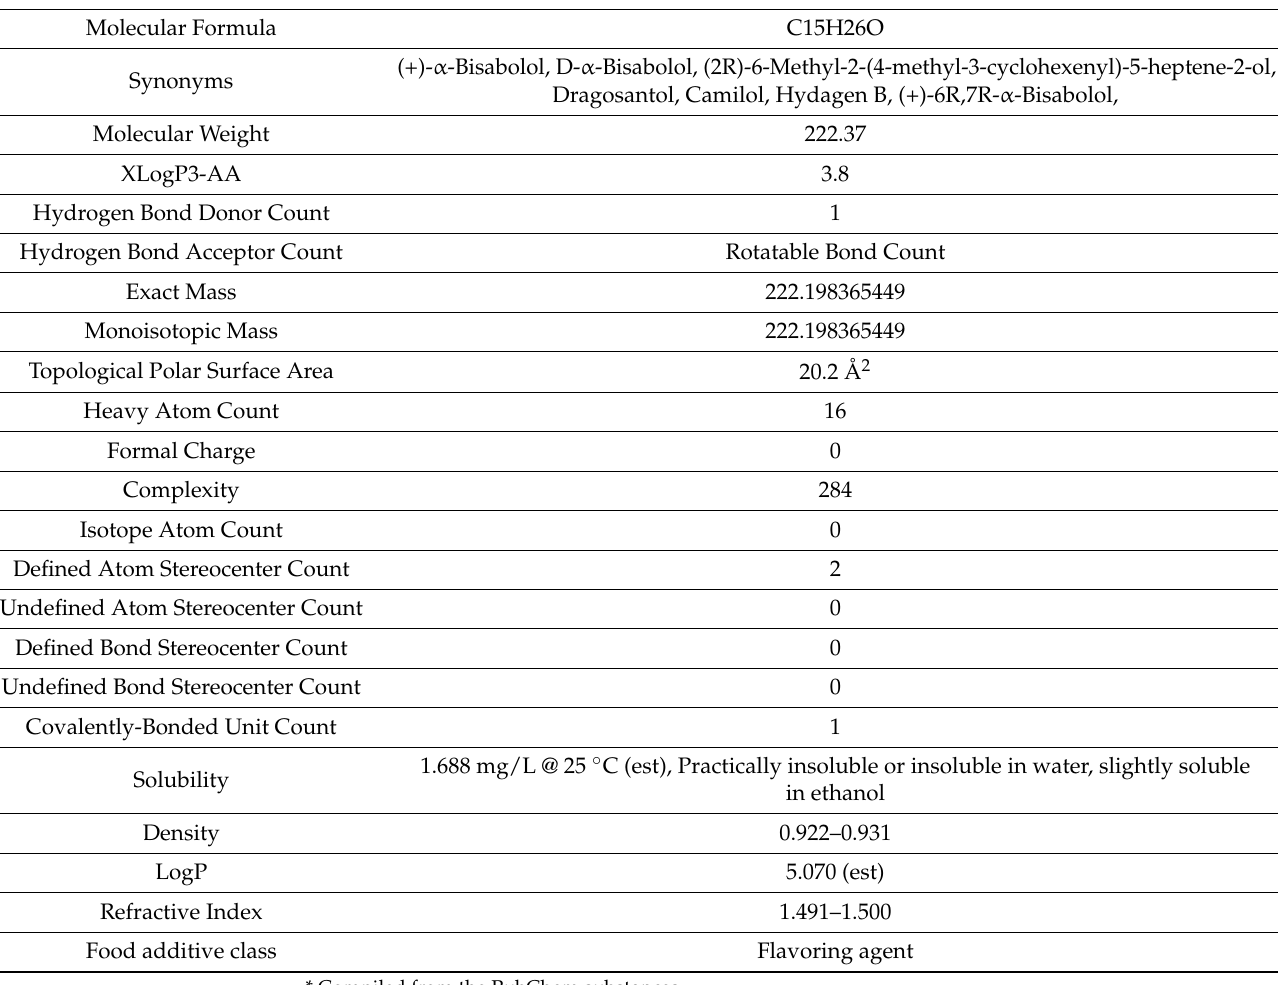
Table 2. * Physicochemical properties of α